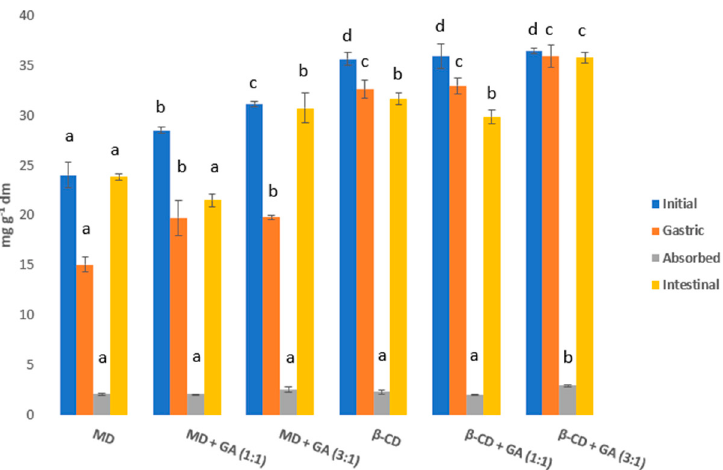
Figure 2. In vitro bioavailability of polyphenols from encapsulated nettle extracts obtained at same conditions (160 °C and sample:carrier ratio 1:3) with different carriers. Values with different letters within phases are statistically different at p < 0.05.